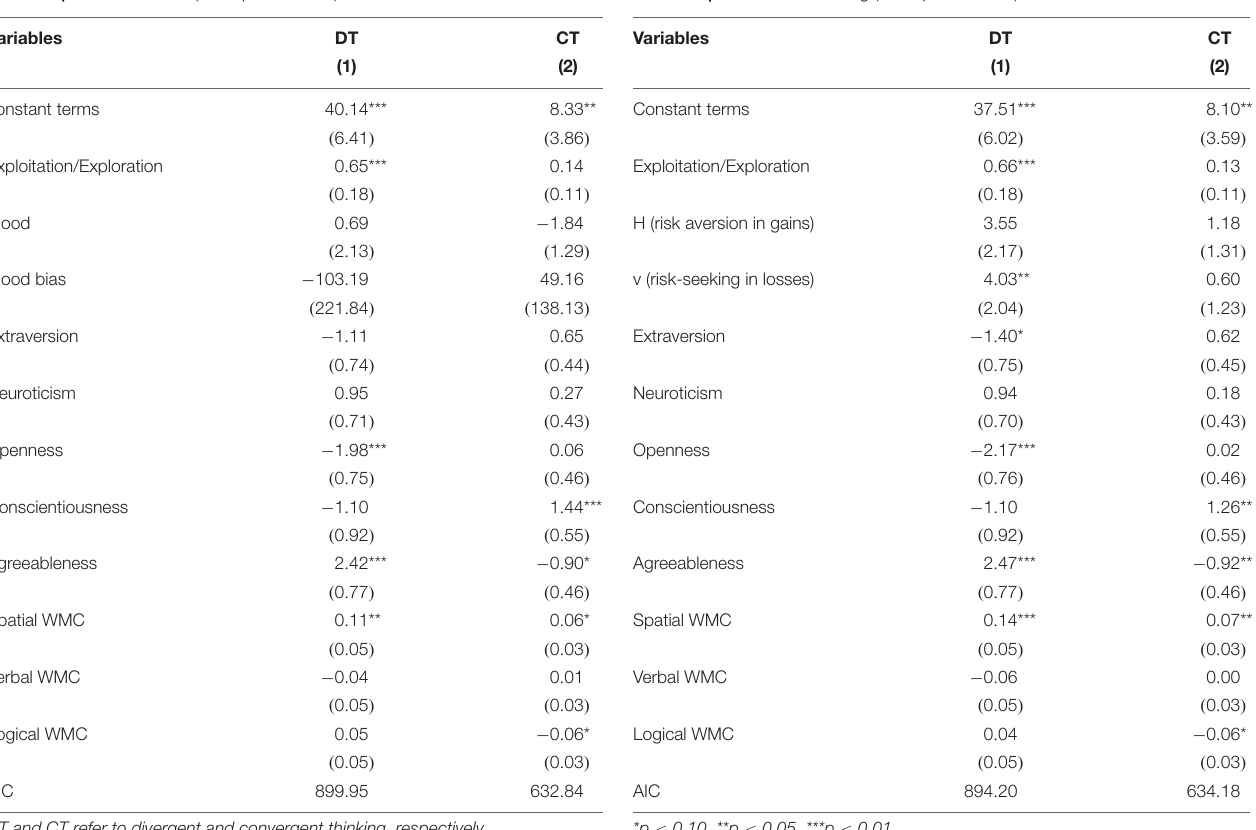
TABLE 2 | Effects of mood (SE in parentheses). TABLE 3 | Effects of risk-taking (SE in